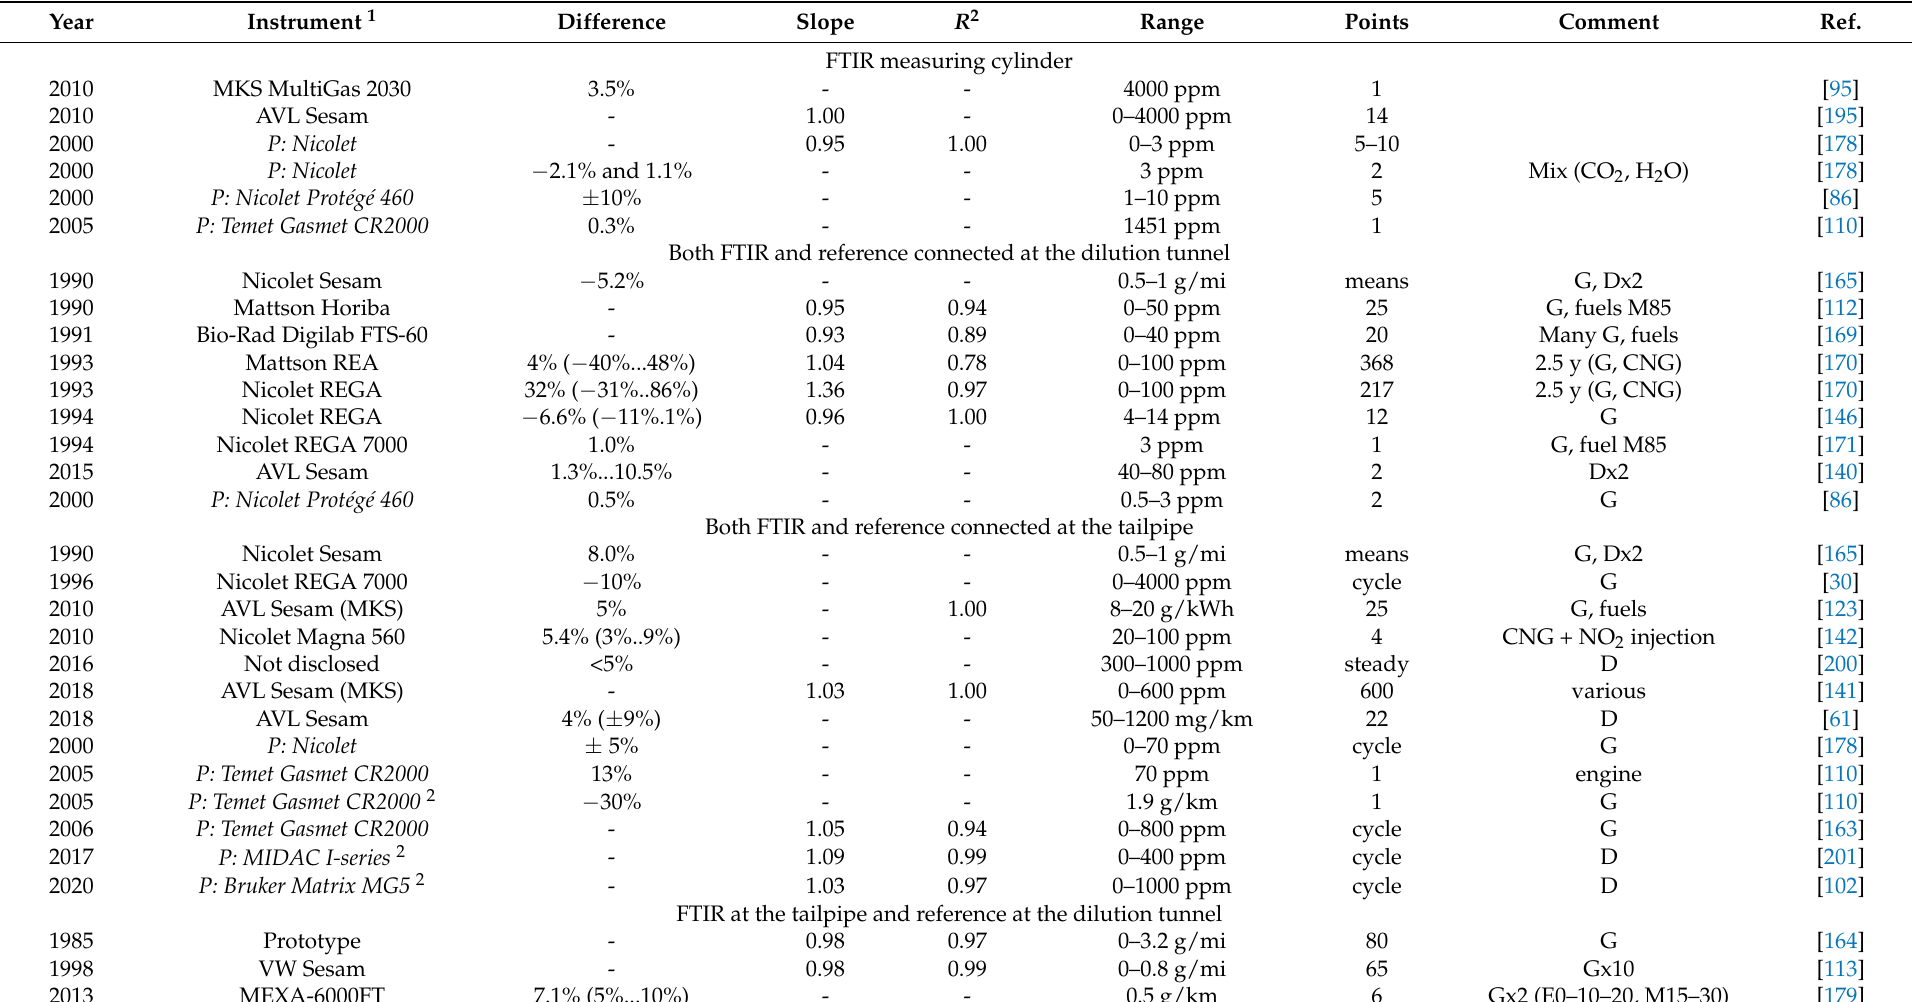
Table A3. Comparisons of FTIR with NO x analyzers (all CLD unless otherwise